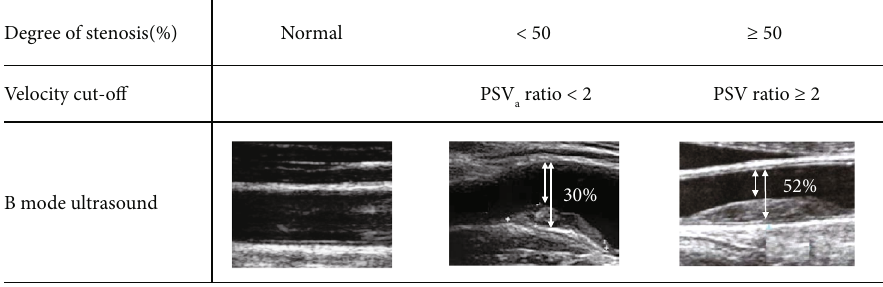
Figure 1: Duplex ultrasonography criteria. PSV: peak systolic velocity.